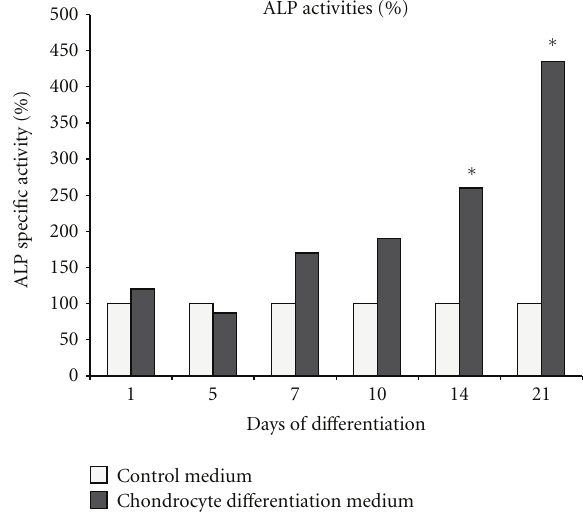
Figure 5: Alkaline Phosphatase (ALP) assay. Statistical analysis using paired t -test. Comparison of data between controls and di ff erentiated groups showed significant di ff erence ( ∗ ) after 14 days and 21 days ( P < 0 . 05; n =